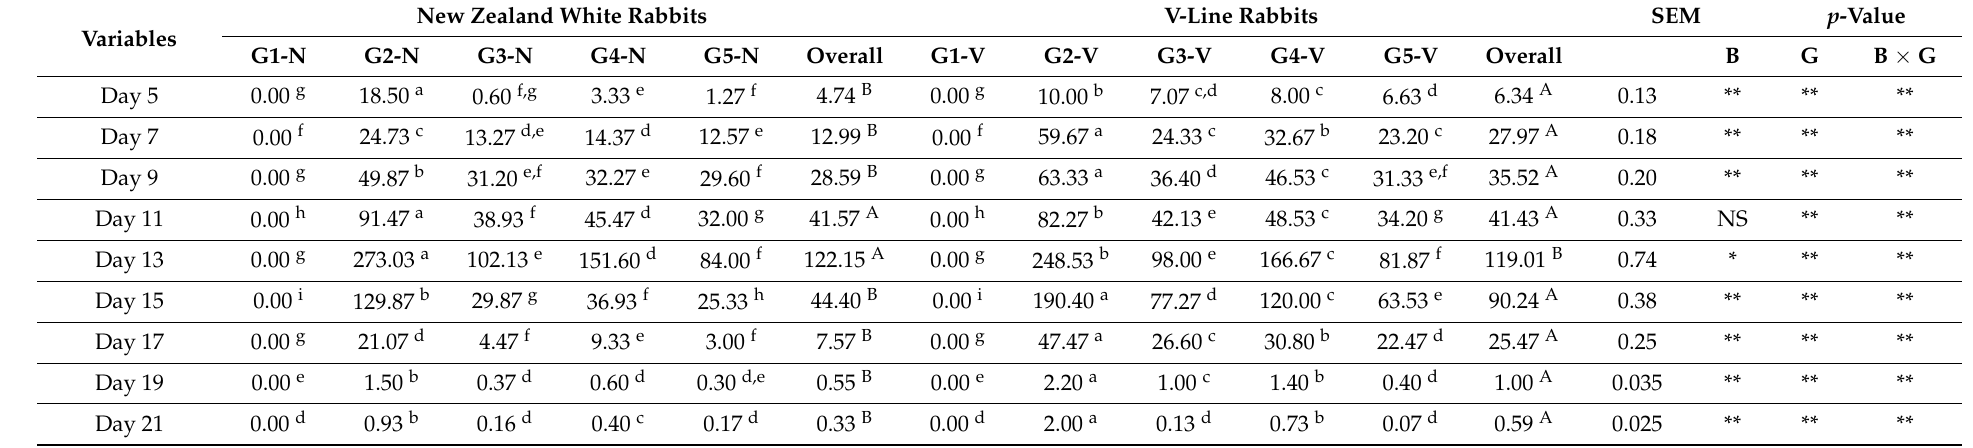
Table 4. Oocyst count per gram of feces (OPG) of the New Zealand white and V-line rabbits in response to coccidial infection and herbal extract treatment.